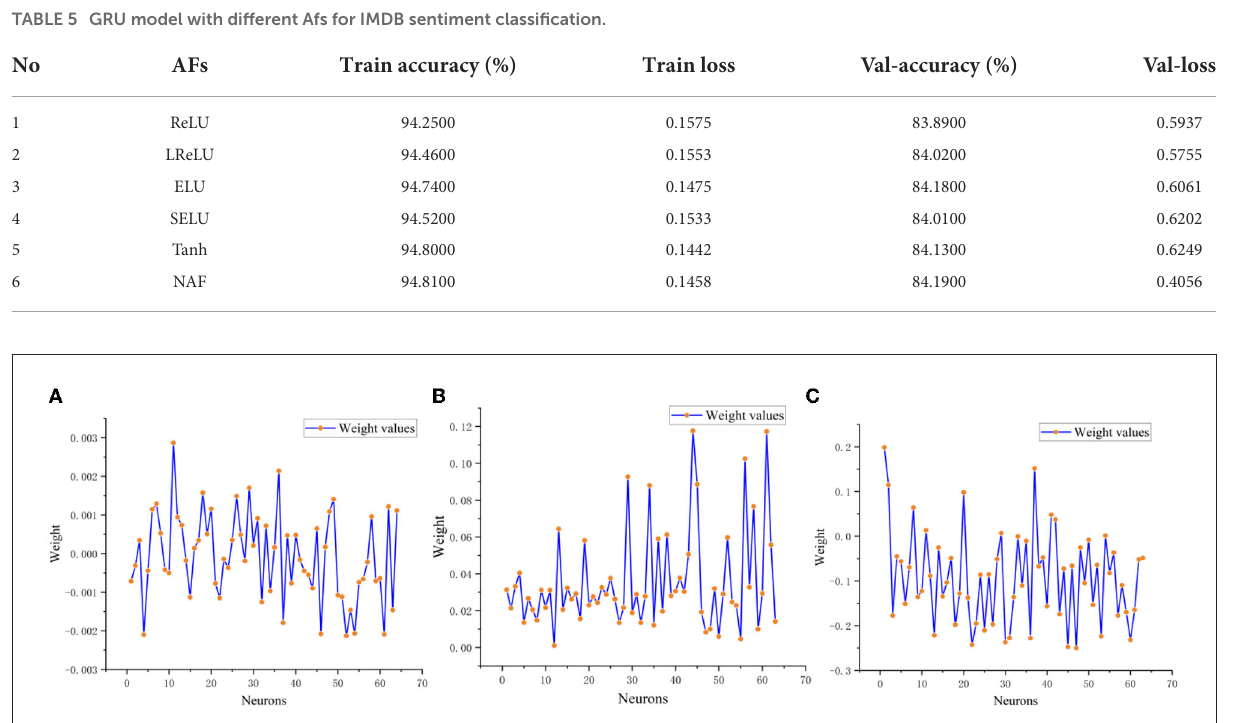
FIGURE10 Output layer weights of SRNN, LSTM, and GRU model. (A) SRNN output layer weights. (B) LSTM output layer weights. (C) GRU output layer weights.